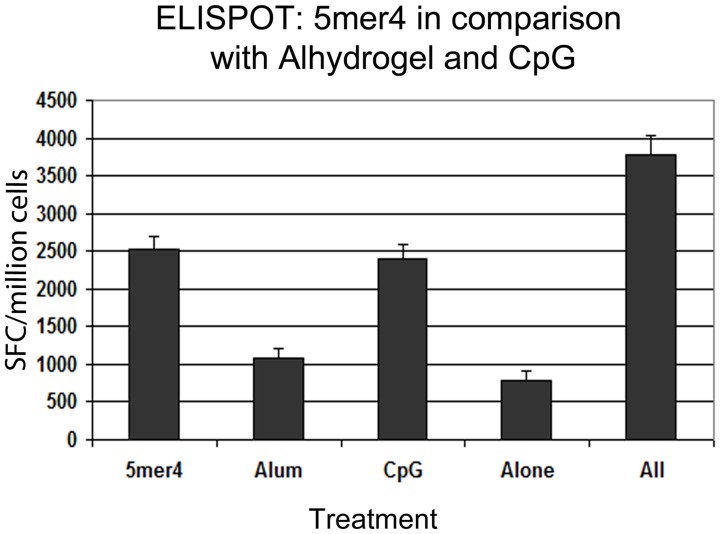
Comparison of 5mer4 with other commercial adjuvants.Groups of 3–4 BALB/c mice were immunized with H5N1-HA (50 µg) alone, H5N1-HA (50 µg) + 5mer4 (50 µg), H5N1-HA (50 µg) + CpG (10 µg), H5N1-HA (50 µg) adsorbed to Alhydrogel (450 µg), or “All” (H5N1-HA + 5mer4 (50 µg) + CpG (10 µg) + adsorbed to Alhydrogel (450 µg). Cellular immune responses were monitored 10 days post-immunization. Splenocytes were re-stimulated with H5N1-HA peptides pools and detected for IFN-γ secretion. The bars represent total pooled T-cell responses. Error bars represent ± SEM.